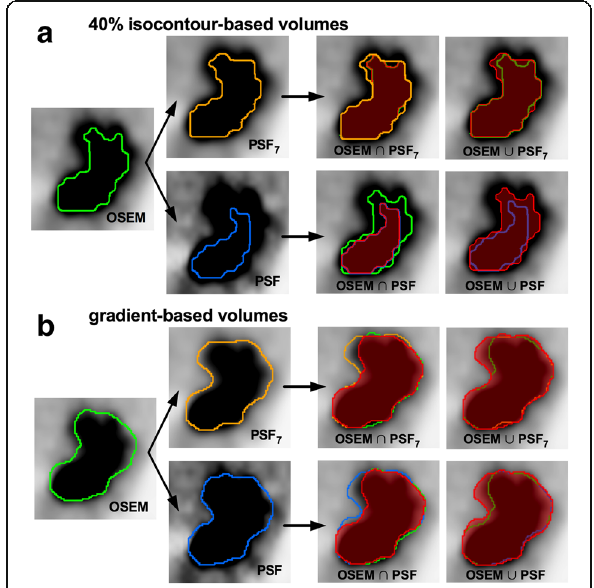
Fig. 2 A representative example of automatic delineation of a tumour. MATVs derived from OSEM, PSF, and PSF 7 reconstructions, as well as their unions and intersections, are shown on axial slices from a 61-year-old patient presenting with a stage IIIA squamous cell lung cancer. Panels a and b display 40% isocontour-based volumes and gradient-based volumes,